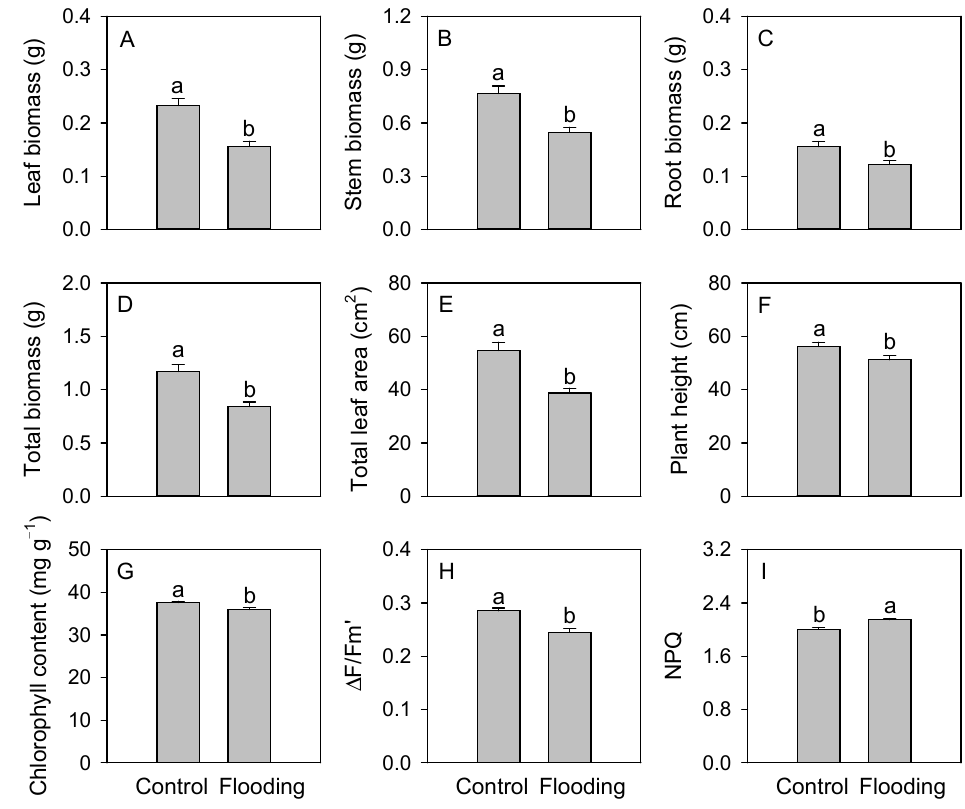
Figure 2. Leaf biomass ( A ), stem biomass ( B ), root biomass ( C ), total biomass ( D ), total leaf area ( E ), plant height ( F ), total chlorophyll content ( G ), effective quantum yield in the light ( Δ F/Fm’, H ), and non-photochemical energy quenching (NPQ, I ) of P. hydropiper under control and flooding treatments. Data are mean values (+s.e., n = 6). Different letters indicate significant differences ( p < 0.05).